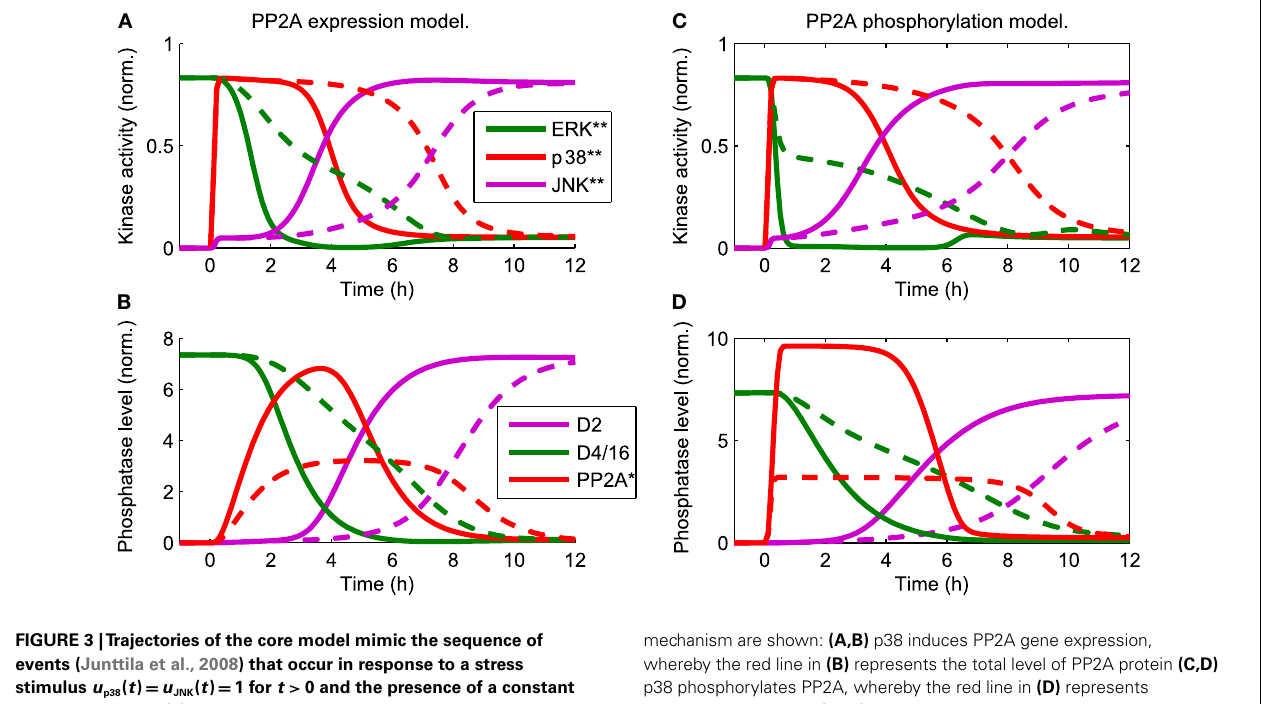
FIGURE 3 |Trajectories of the core model mimic the sequence of events (Junttila et al., 2008) that occur in response to a stress stimulus u p38 ( t ) = u JNK ( t ) = 1 for t > 0 and the presence of a constant mitotic signal u ERK ( t ) = 1 for all t . D2 and D4/16 denote DUSP2 and DUSP4/16, which mediate the JNK (cid:97) ERK, p38, and ERK (cid:97) JNK crosstalks, respectively (see also Table 1 ).The qualitative behavior is independent of the mechanistic details implementing p38-PP2A interaction.Two